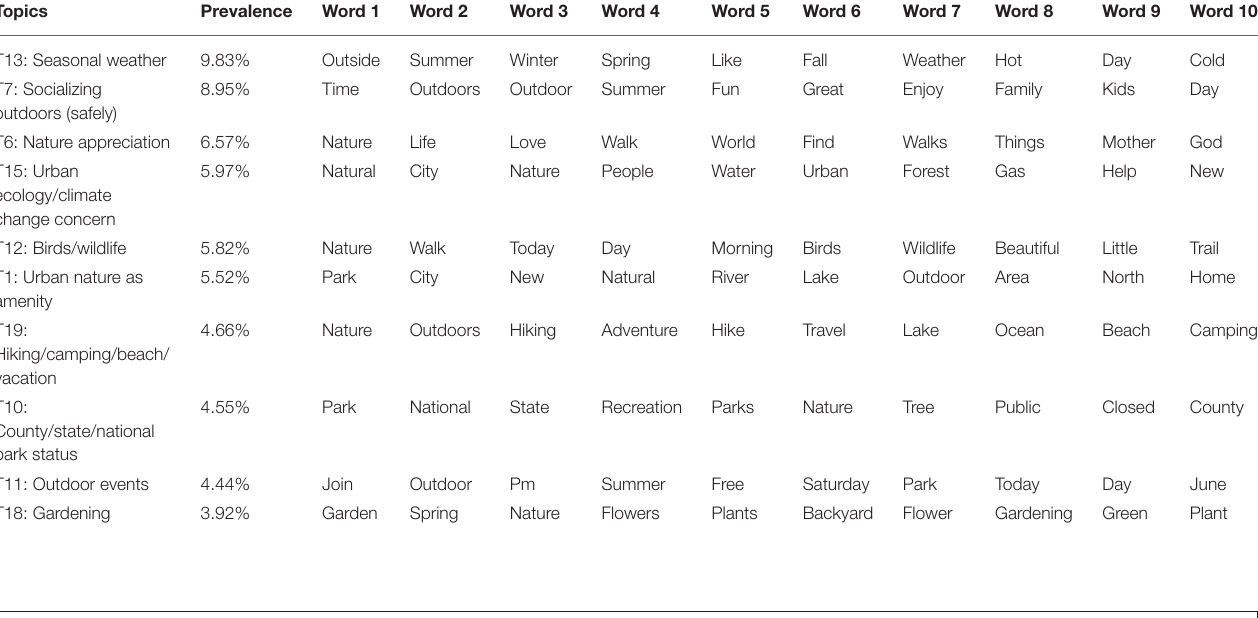
TABLE 3 | Topic prevalence and top 10 words for nature-themed topics. Topics